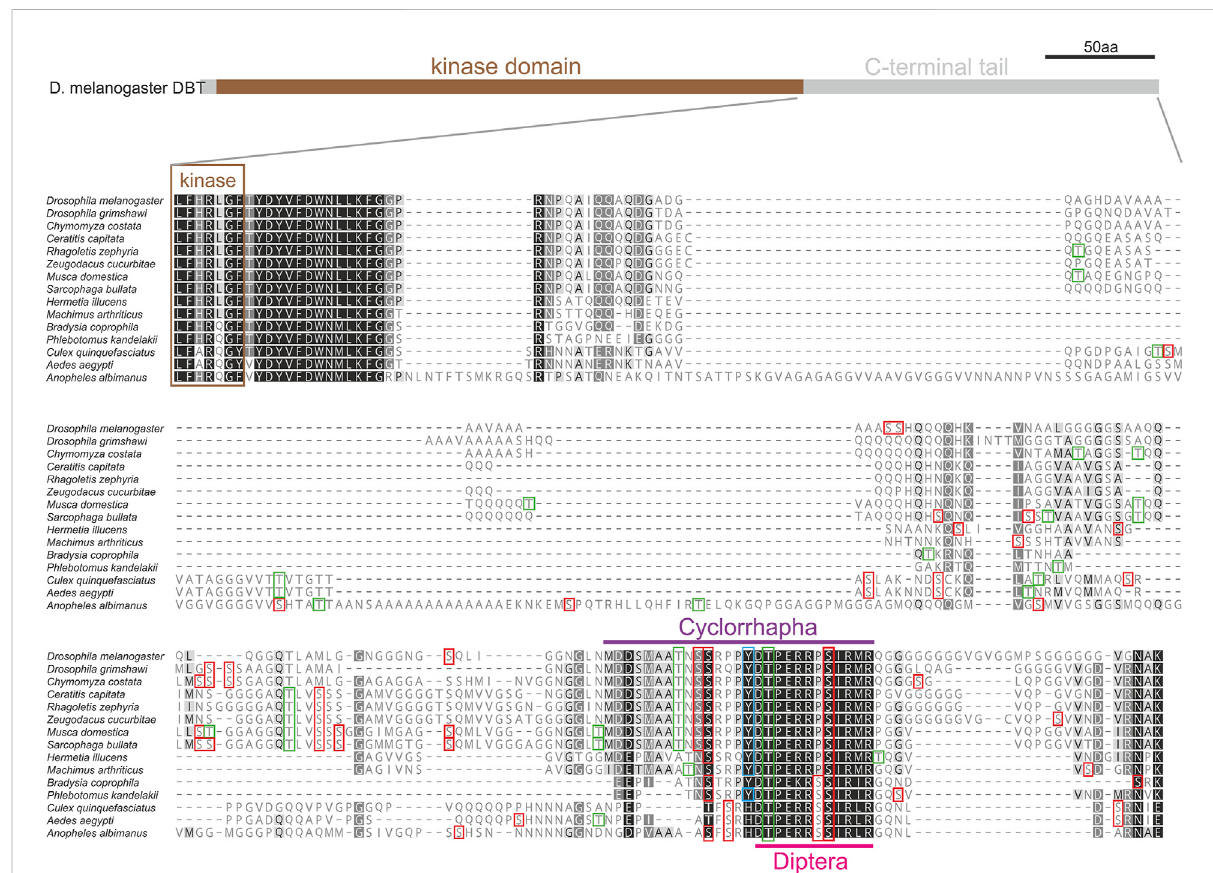
FIGURE 7 C-terminal tail of DBT in 15 representative species of Diptera. Protein alignment points to variable and conserved regions in the protein sequence (the more conserved the darker the color; a hyphen corresponds to a gap in the alignment). Color rectangles refer to the theoretical prediction of phosphorylation pattern ( > 0.5, NetPhos-3.1) for serin (S), threonine (T), and tyrosine (Y). The C-terminal tail contains a motif conserved in Diptera (light purple), which can be further extended in Cyclorhapha (Deep